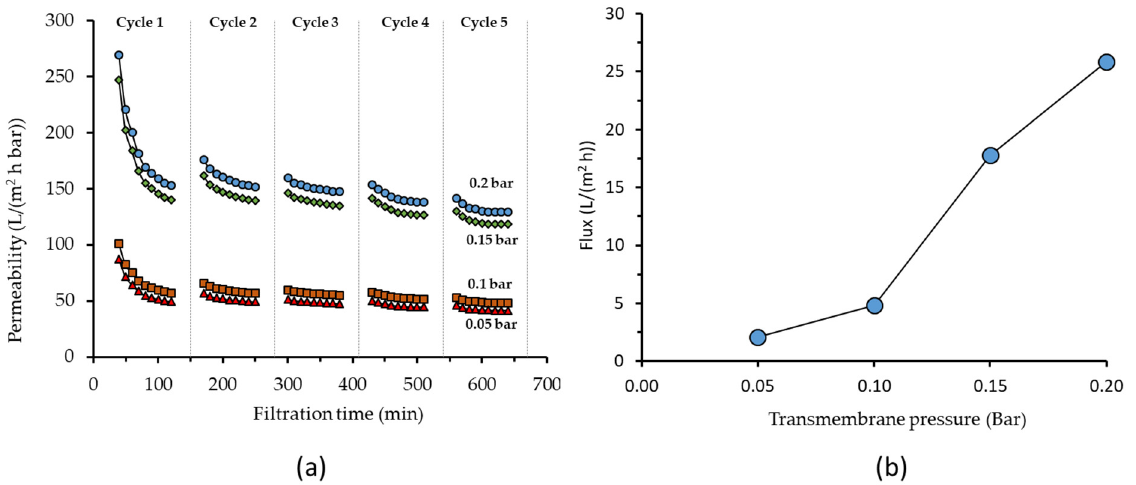
Figure 4. Effect of transmembrane pressure (TMP) on ( a ) permeability as function of filtration time and ( b ) flux from the final reading of the last filtration cycle of PSF/PEG-60 membrane treating 1000 ppm oil/water emulsion under various TMP. The first 30 min of filtration in the first cycle was done for clean water permeability measurement.